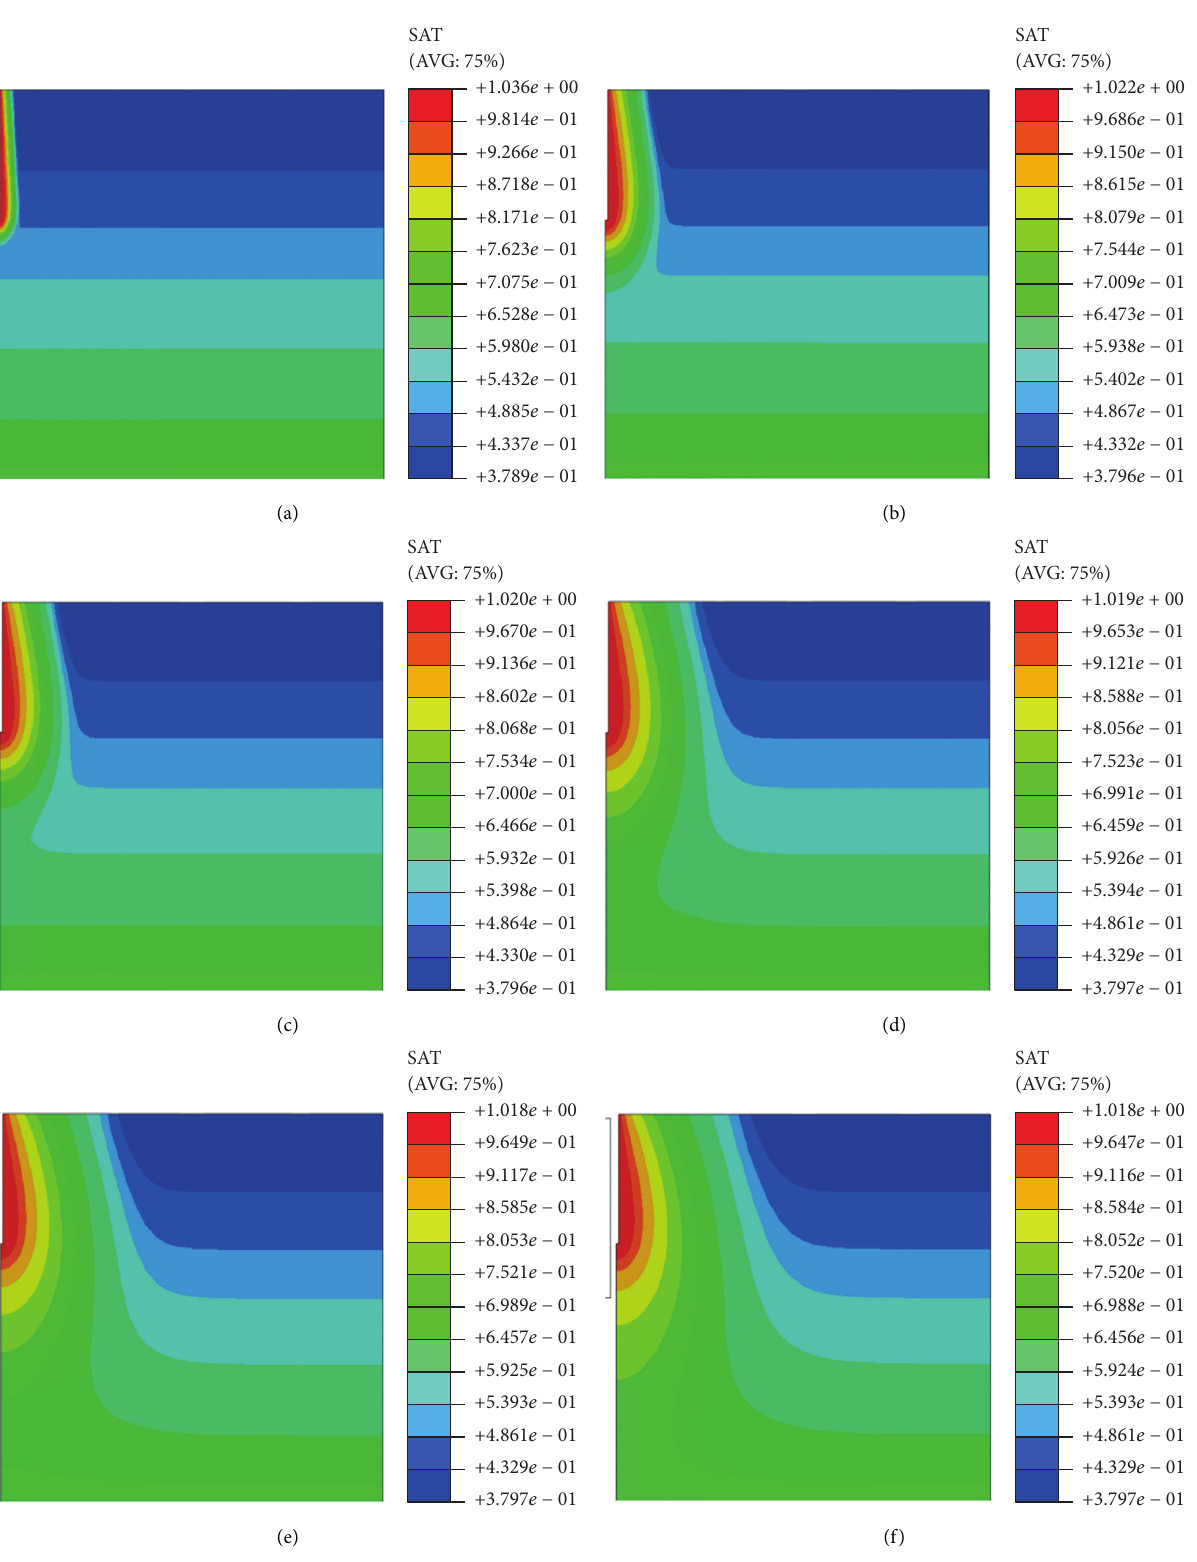
Figure 6: Saturation distribution nephogram of a single water injection hole at different time points: (a) 1h; (b) 12h; (c) 1 d; (d) 3d; (e) 5d; (f) 7